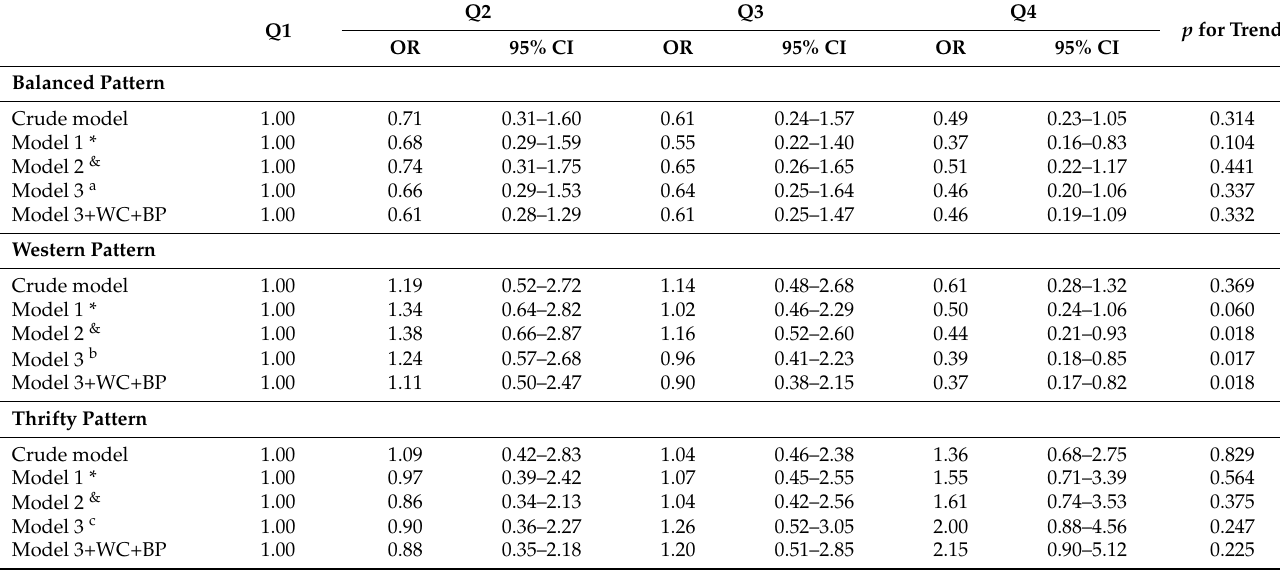
Table 6. Association between low HDL-C and quartiles of dietary patterns in the older participants by BMI subgroups (21.6 <= BMI < 24.8 kg/m 2